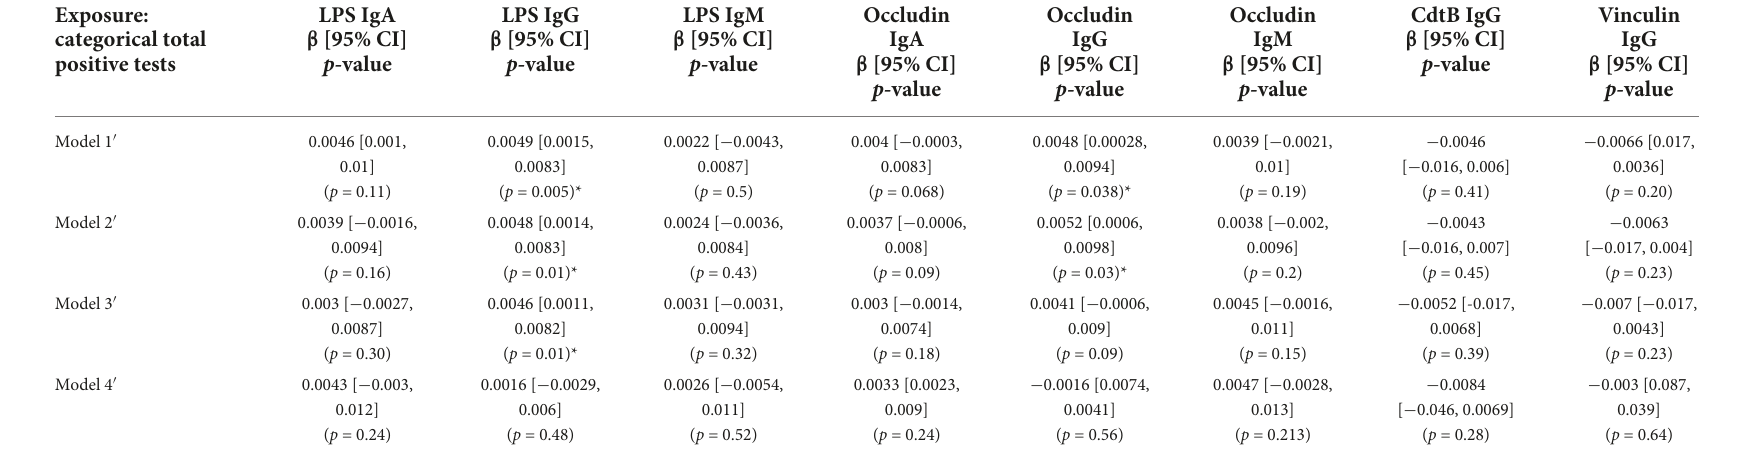
TABLE 3 Associations between intestinal permeability biomarkers and categorical summed food sensitivity measures ( n = 111).